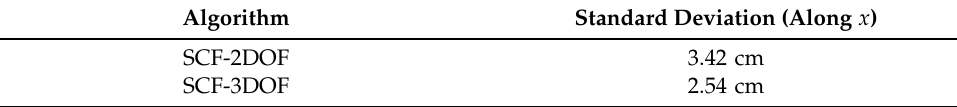
Table 2. Standard deviation of the position error along the x -axis for different algorithms.